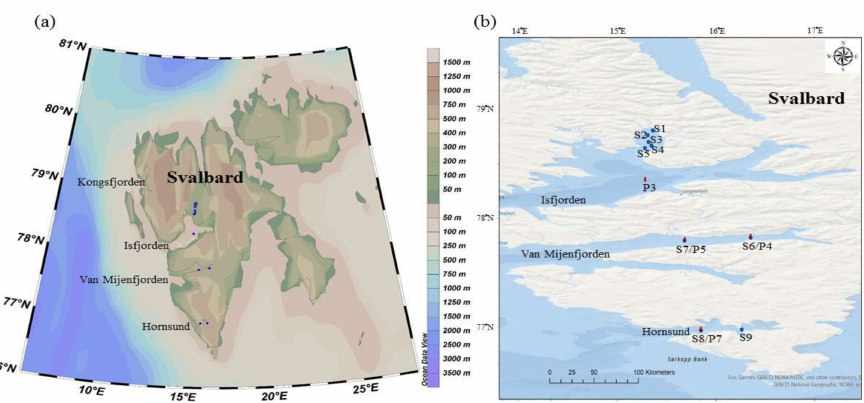
Figure 1. Map of fjords in the West Svalbard ( a ). The sampling sites for seawater (S1–S9, blue circles in ( b )) and pore waters (P3–P5 and P7, red pin which overlapped with blue circles in ( b )) in the West Svalbard from the 18th to 23rd of July 2016. The original site names are available in Table S1. Figure 1a was produced with ODV software